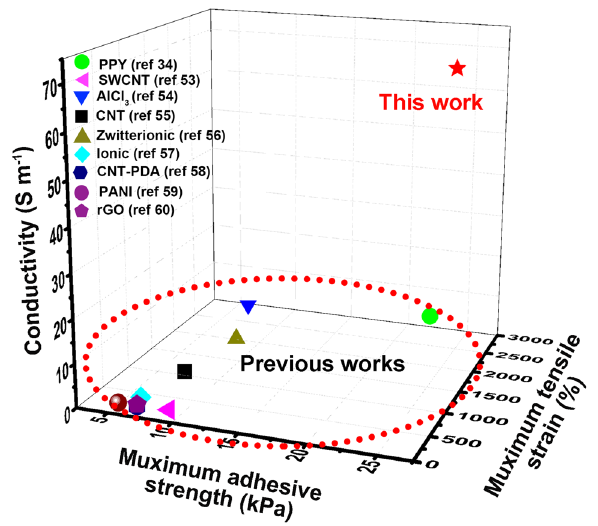
Fig. 7 Comparison of this work with previous reported conductive hydrogels in terms of stretchability, adhesiveness, and